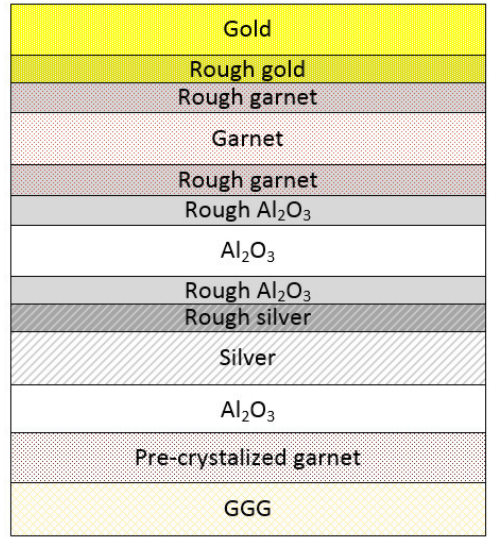
Figure 3. The schematics of the structure used for the modeling of the optical spectra of the samples-1, 2 and 3. The roughnesses of the gold, silver and iron garnet layers were taken into account by introducing “sublayers” (marked as “rough” gold, iron garnet, Al respectively) having the imaginary parts of their permittivity function increased q